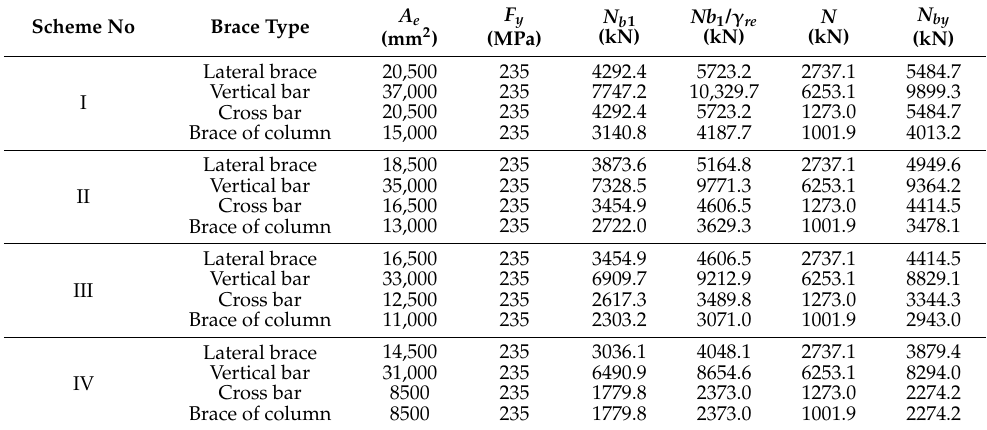
Table 6. Design parameters of